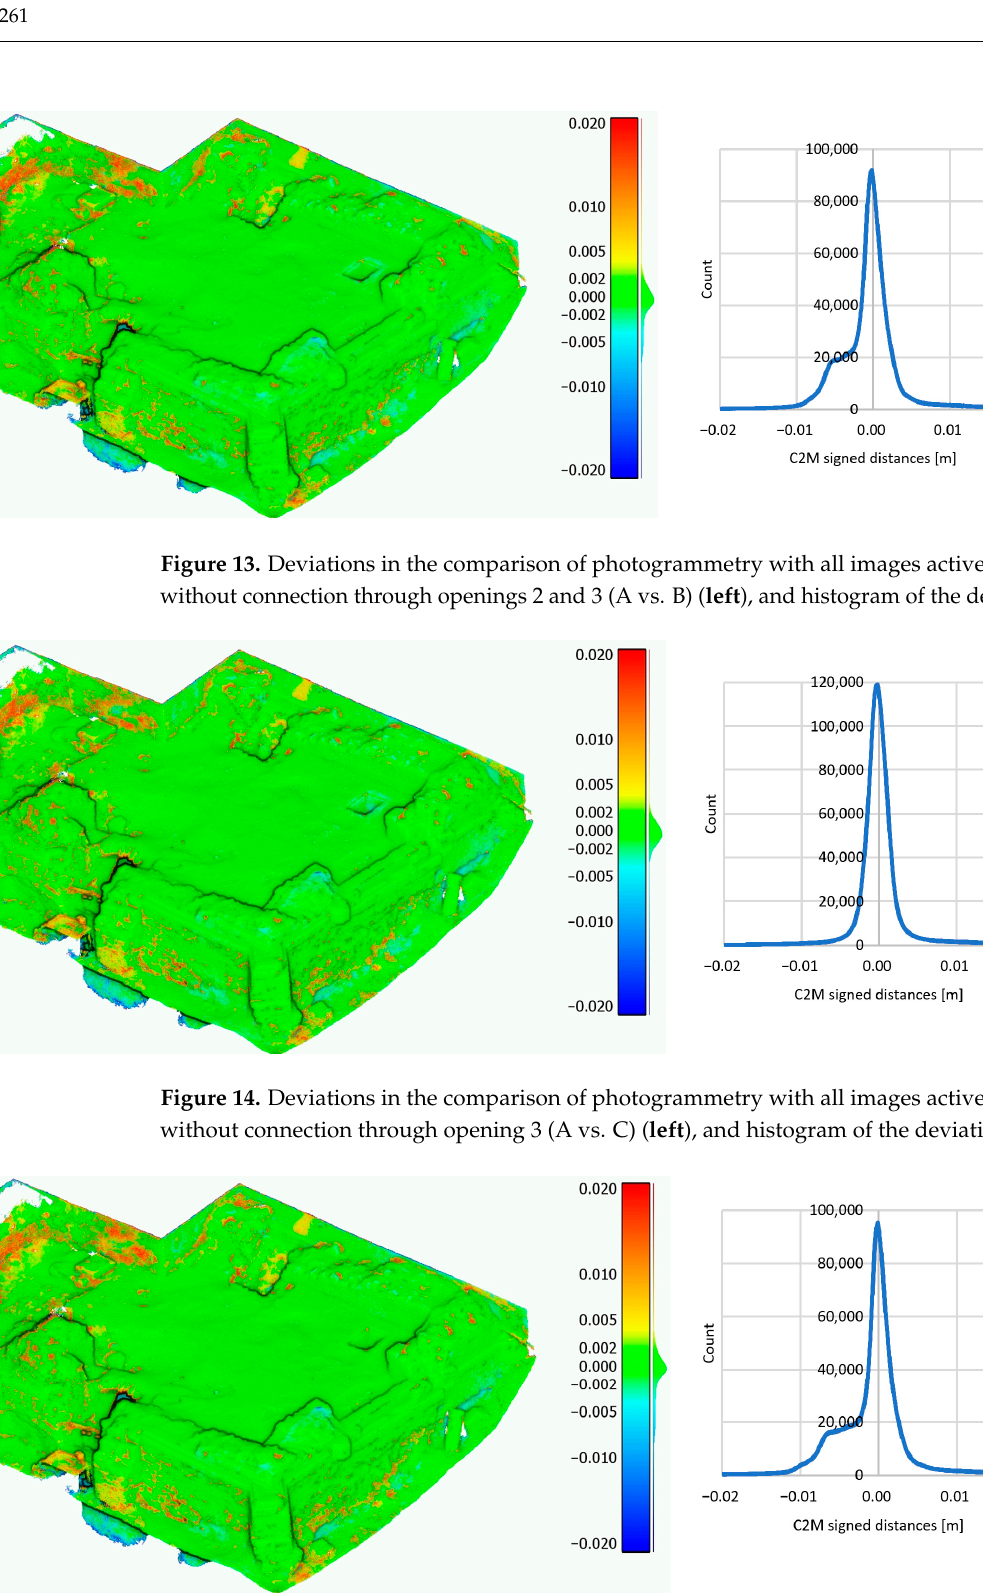
Appl. Sci. 2023 , 13 , 261 11 of 16 4.2. Photogrammetric Variants B, C, and D vs. the Reference Photogrammetric Variant A When comparing the photogrammetric variants, an effect of the relative change in the configuration of the camera network was only present in the ossuary, as there were